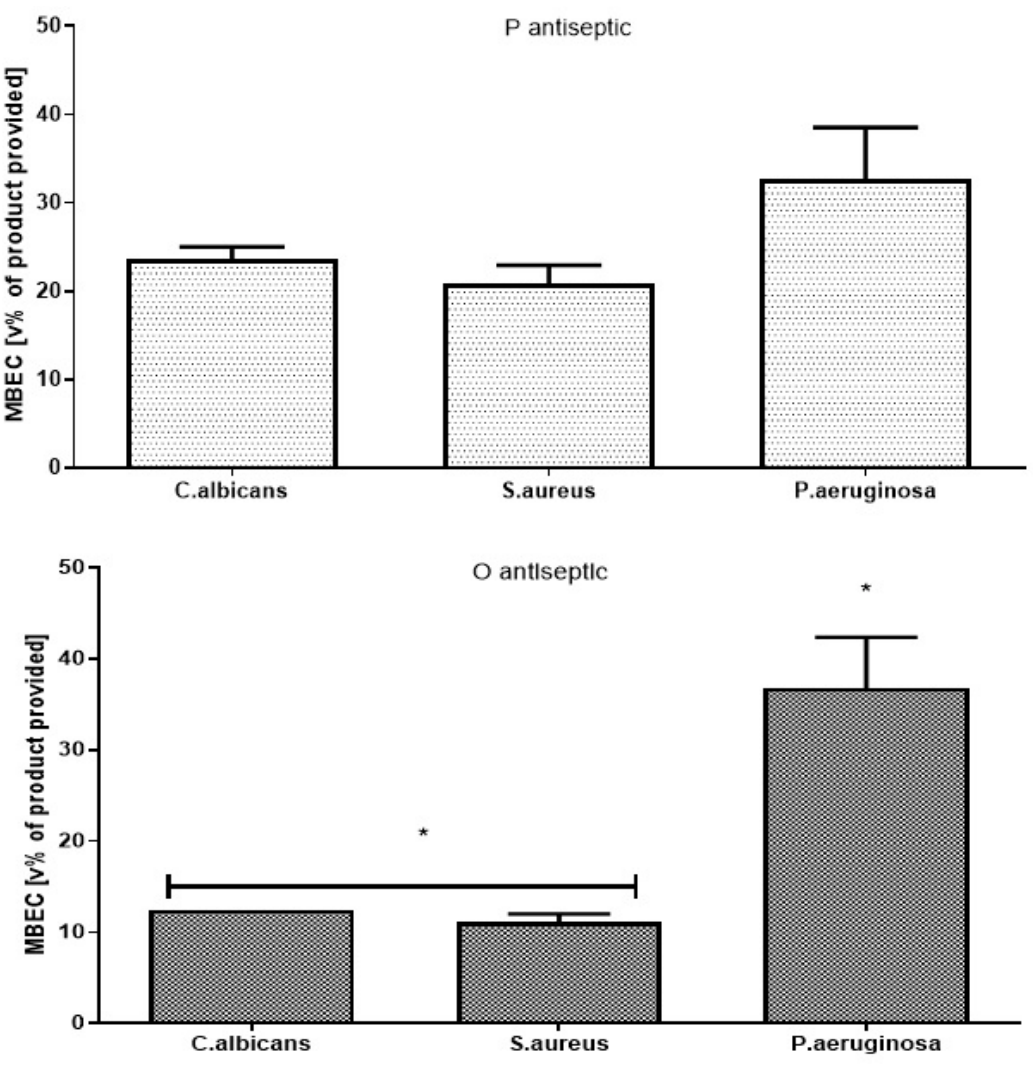
Figure 1. Minimal biofilm eradication concentration (MBEC) of P and O antiseptics against the tested strains (n = 9) of C. albicans , S. aureus , P. aeruginosa . In the case of the M antiseptic, the MBEC value for all pathogenic biofilms tested was higher than the maximum concentration (i.e., 50% of the volume of the product provided) which could be applied according to this methodology. The asterisks (*) in the bottom figure show a statistically significant difference between the ability of the O- antiseptic to eradicate P. aeruginosa biofilms vs. C. albicans and S. aureus biofilms; p < 0.05). P, O—polihexanide, octenidine dihydrochloride-based antiseptic, respectively.